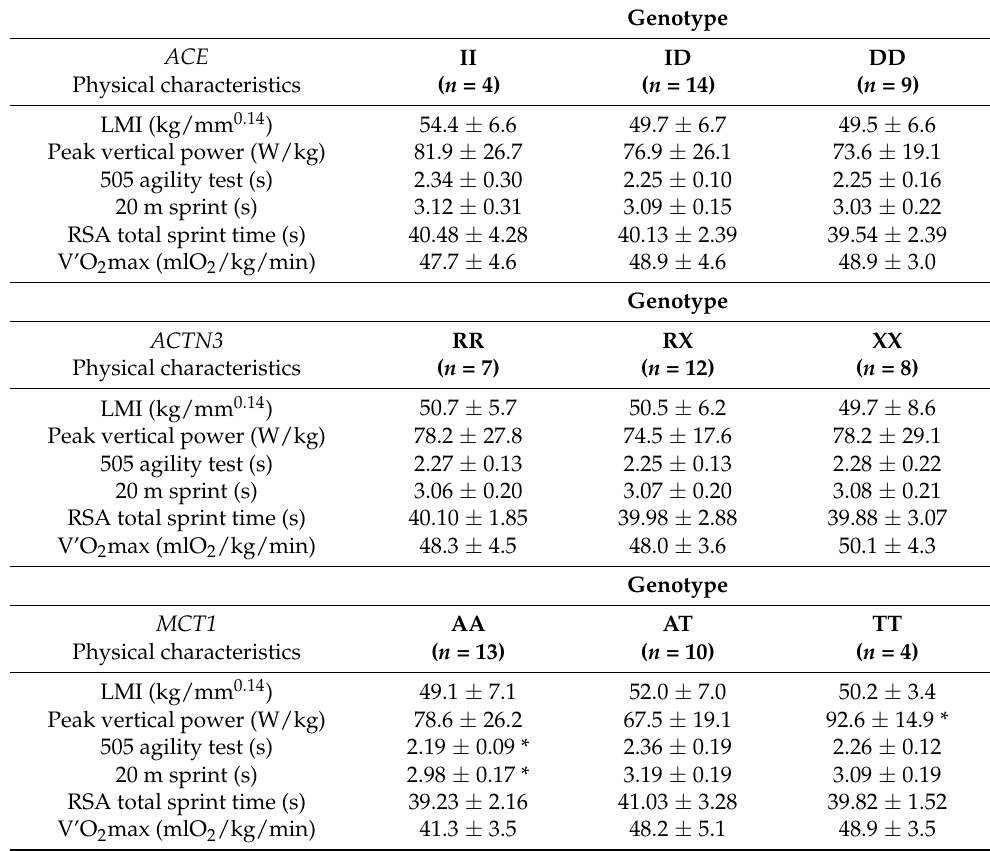
Table 3. ANOVA for physical characteristics of elite rugby union players; relative to ACE , ACTN3 and MCT1 genotypes.